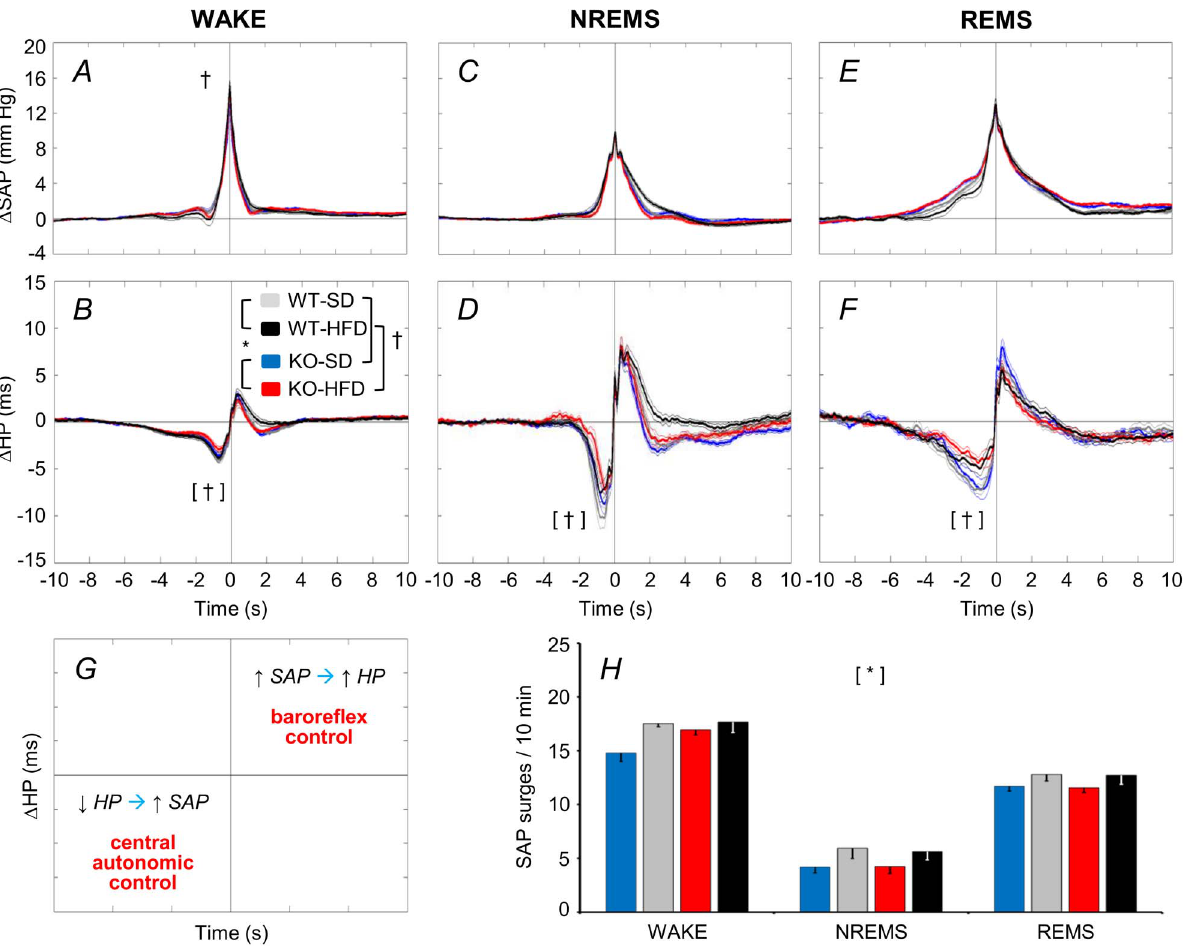
Figure 5. Coherent averaging of spontaneous surges of arterial pressure. The panels show time series of D SAP (A, C, E) and D HP (B, D, F) during spontaneous SAP surges (detection threshold=5 mm Hg) during WAKE, NREMS, and REMS over 48 hours including light and dark periods. The time series were normalized by subtracting the respective baseline values and synchronized at the SAP peak. Panel G summarizes the interpretation [22]. A D HP trough (i.e., cardiac acceleration) preceding a SAP surge is consistent with central autonomic control of the heart. A positive D HP peak (i.e., cardiac slowing) following a SAP surge is consistent with baroreflex cardiac control. Statistical analysis in panels A–F was performed on D SAP and D HP peaks and the D HP nadir. Panel H shows the frequency of spontaneous SAP surges per 10 min of each wake-sleep state. Data are means 6 SEM for KO and WT mice fed a SD or a HFD, with n=9–10 per group. Detailed ANOVA results are reported in Table S4. For abbreviations and symbols see Figures 1 and